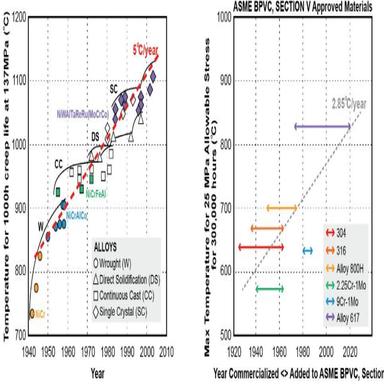
(left) History of improvement in temperature capability of Ni based superalloys, redrawn from , (right) history of improvement in temperature capability for ASME BPVC Section V approved materials.